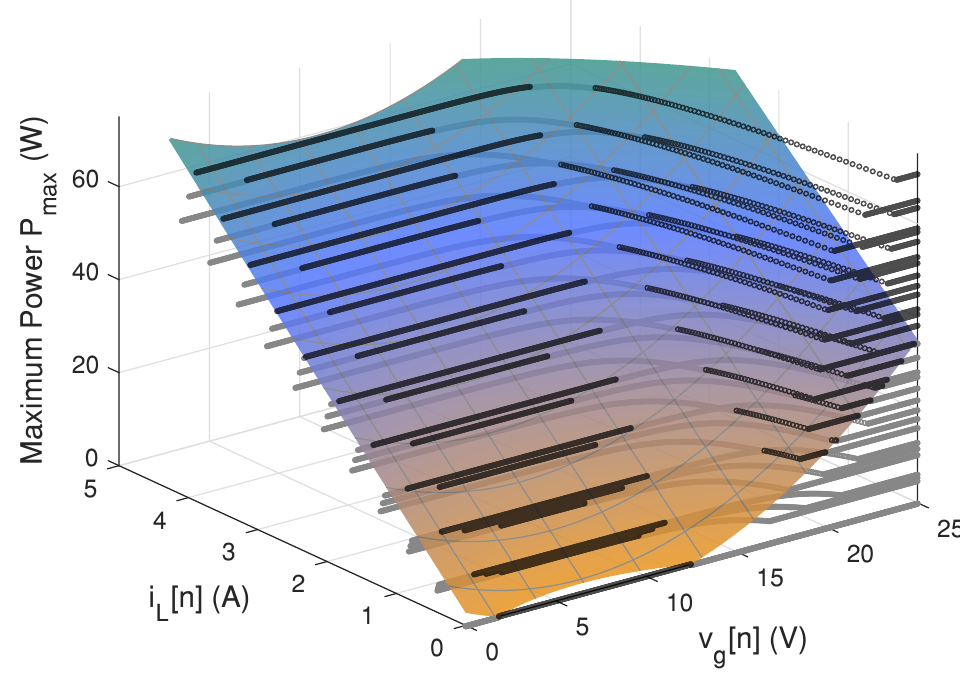
Figure 3. Plotting of the MPP surface in terms of i L [ n ] and v g [ n ] . The goal for the validation and implementation of the MPPT-SPF is maximizing, at any moment during its operation, the available energy of the connected solar modules. The MPPT is obtained by varying the voltage and current so that the PV system outputs the highest possible power at different weather